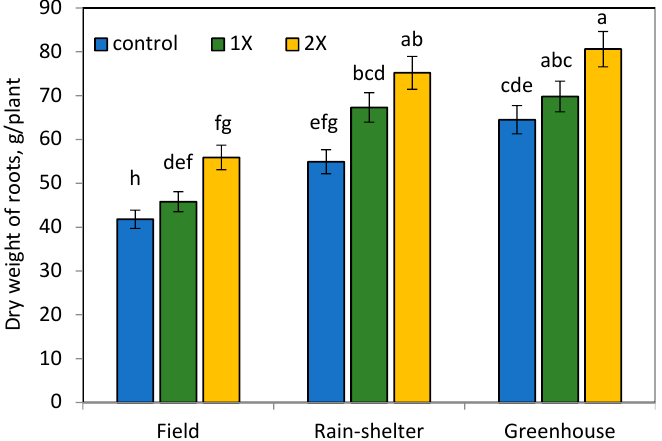
Figure 3. Dry weight of shoot weight per plant (g) at 130 DAT. Means separated by same lower case letter in each column are not significantly different at p < 0.05 among treatments. The enhanced plant development in response to organic manure application is well-known [24], exhibiting a significant steady increase in plant growth due to the improved nutrient conditions in the root rhizosphere. Although organic manure application did not bring any significant difference at the beginning of growing season, the growth parameters were significantly higher at both rates of organic manure treatment at 130 DAT (Table 4). The application of organic manure at the 1× and 2× rates significantly increased chilli pepper growth and N uptake, but the 1× rate treatment stabilized the biomass ratio x plant yield interrelations. However, the organic manure based nutrient management scheme efficiently increased plant growth in all combinations of elevated temperature.